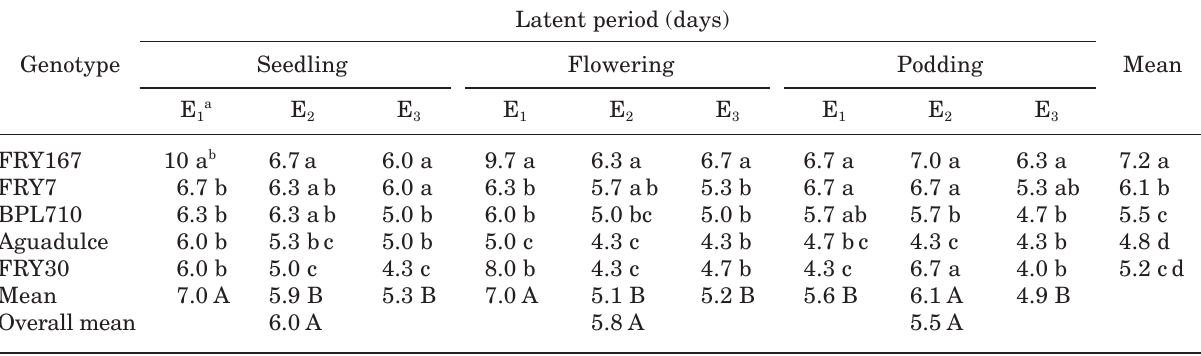
Table 2. Effect of growth stage and leaf age on the latent period in the leaflets of five faba bean genotypes inoculated with Botrytis fabae.